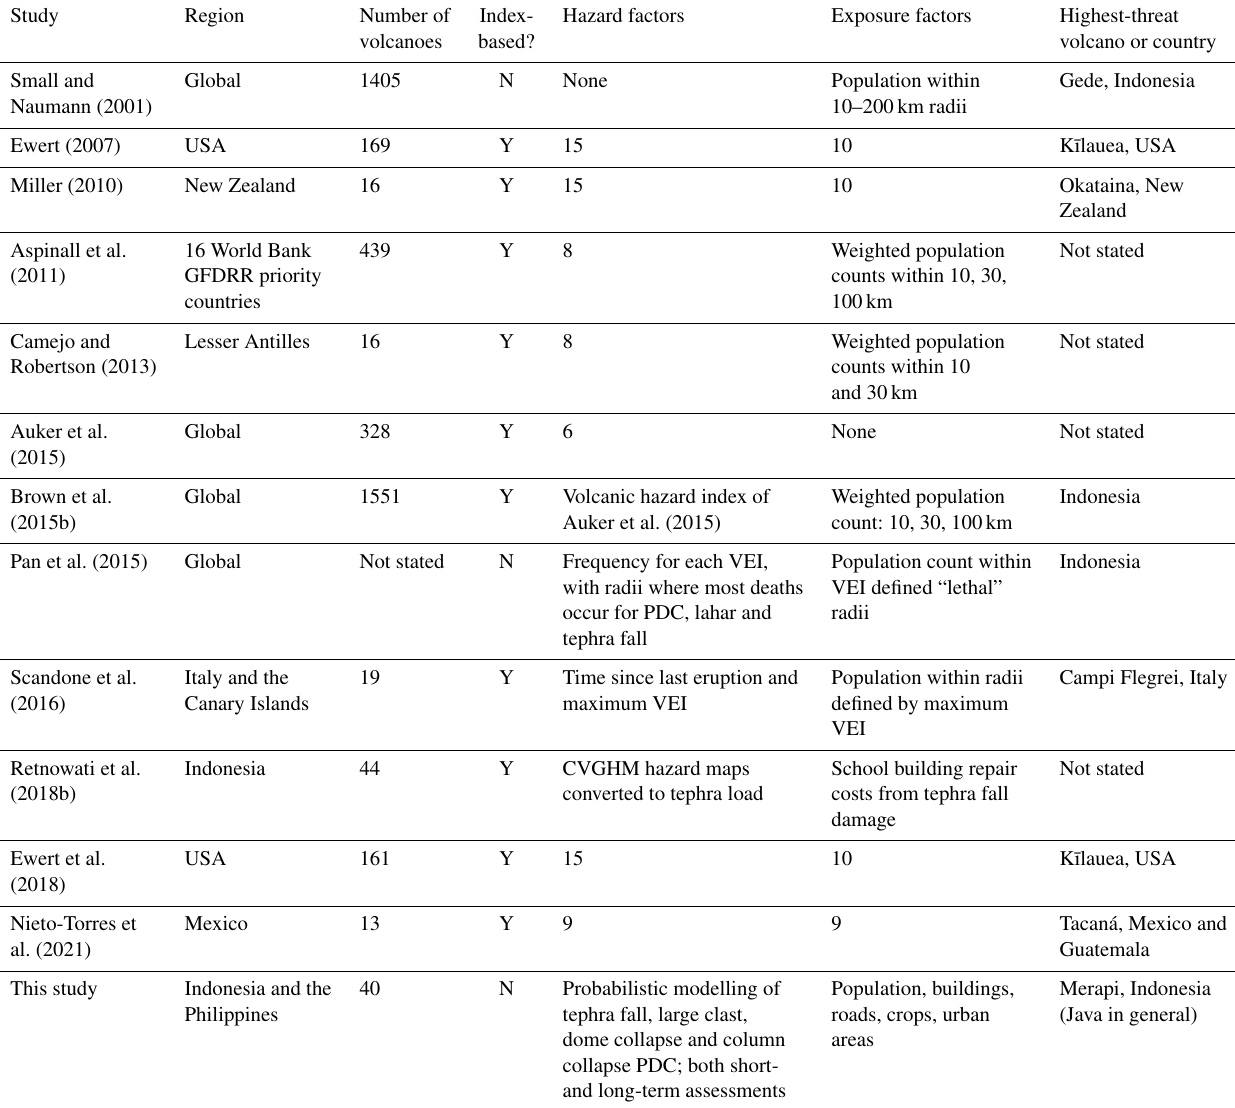
Table 1. Previous studies (in chronological order since 2000) that have compared volcanic hazard, exposure and/or a combination of the two (“threat”) across multiple individual volcanoes to provide a rank. Hazard or exposure factors are listed when there are three or fewer factors. Studies that ranked countries or regions rather than individual volcanoes (e.g. Dilley et al., 2005; Simpson et al., 2011; Freire et al., 2019) and studies that considered the hazard to a site such as a city or key infrastructure site rather than from a volcano (e.g. Jenkins et al., 2012a, b, 2018; Magill and Blong, 2005a, b) are not included